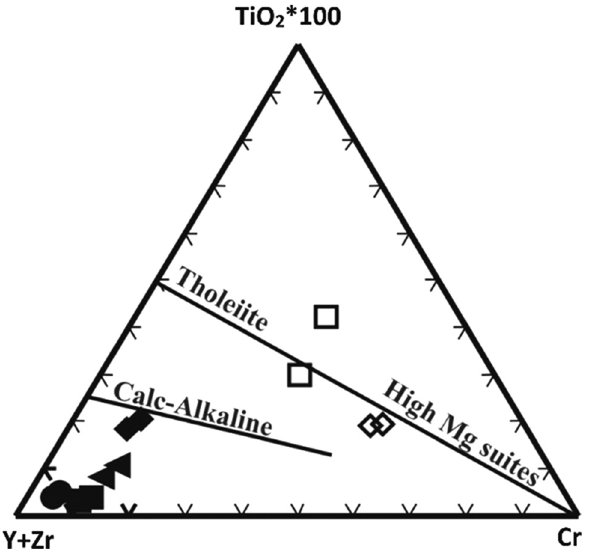
Figure 9: TiO 2 vs Zr diagram for di ff erent dikes, after Pearce [ 28 ] ; symbols as in Figure